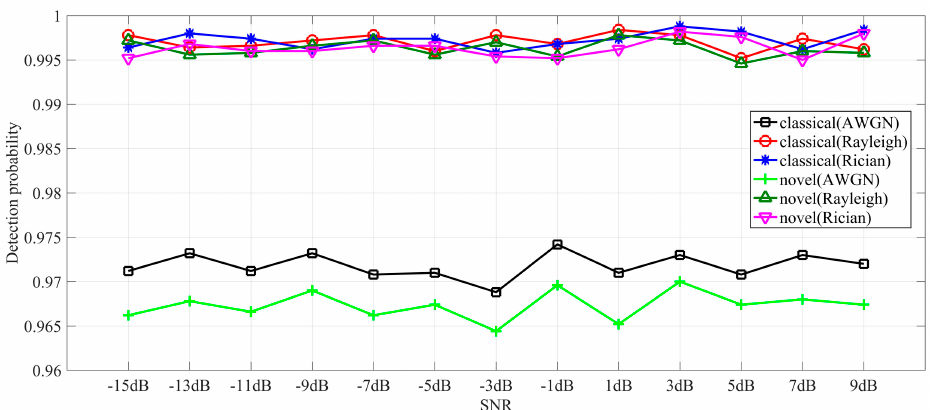
Figure 3. Detection probability comparisons when sensing performance is optimal.